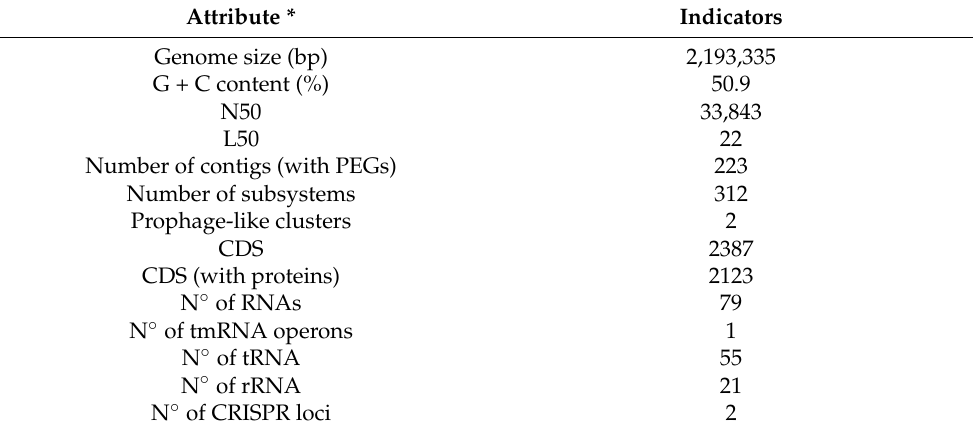
Table 1. The genome contains 2123 protein-coding sequences (CDS). Table 1. Characteristics of the assembly of L. fermentum ATCC 23271 genome.